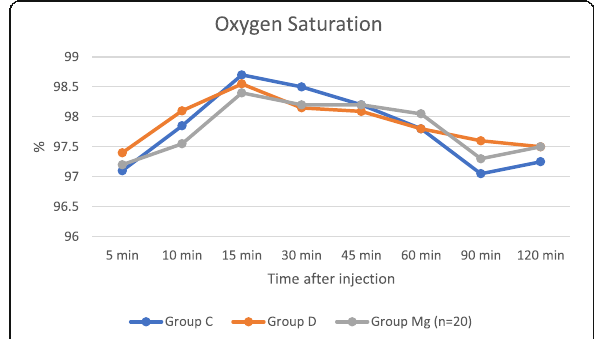
Fig. 4 Linear chart of oxygen saturation between the three